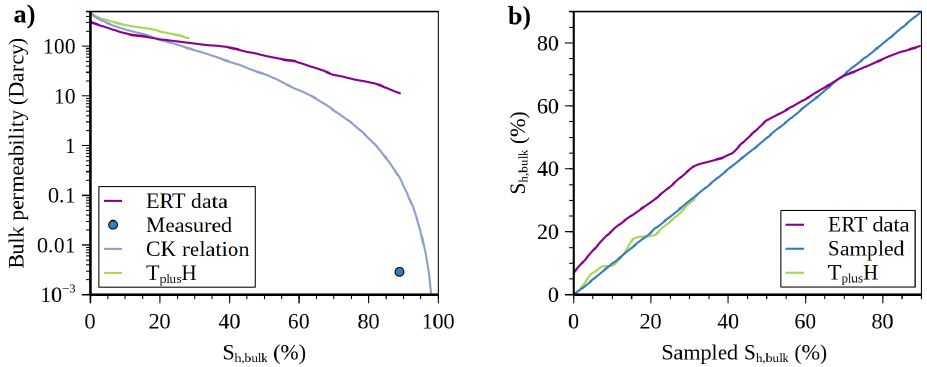
Figure 8. Observed and simulated bulk permeability alongside with the bulk hydrate saturation (S h,bulk ) evolution during the hydrate formation experiment: ( a ) comparison of the simulated volume- averaged permeability with the numerically inversed ERT results [27], the Carman–Kozeny relation as a function of S h,bulk , and the bulk permeability determined by hydraulic testing (blue dot) [27] at the end of experiment [27]; ( b ) comparison of the simulated S h,bulk against the sampled and ERT-measured ones, modified from Priegnitz et al.